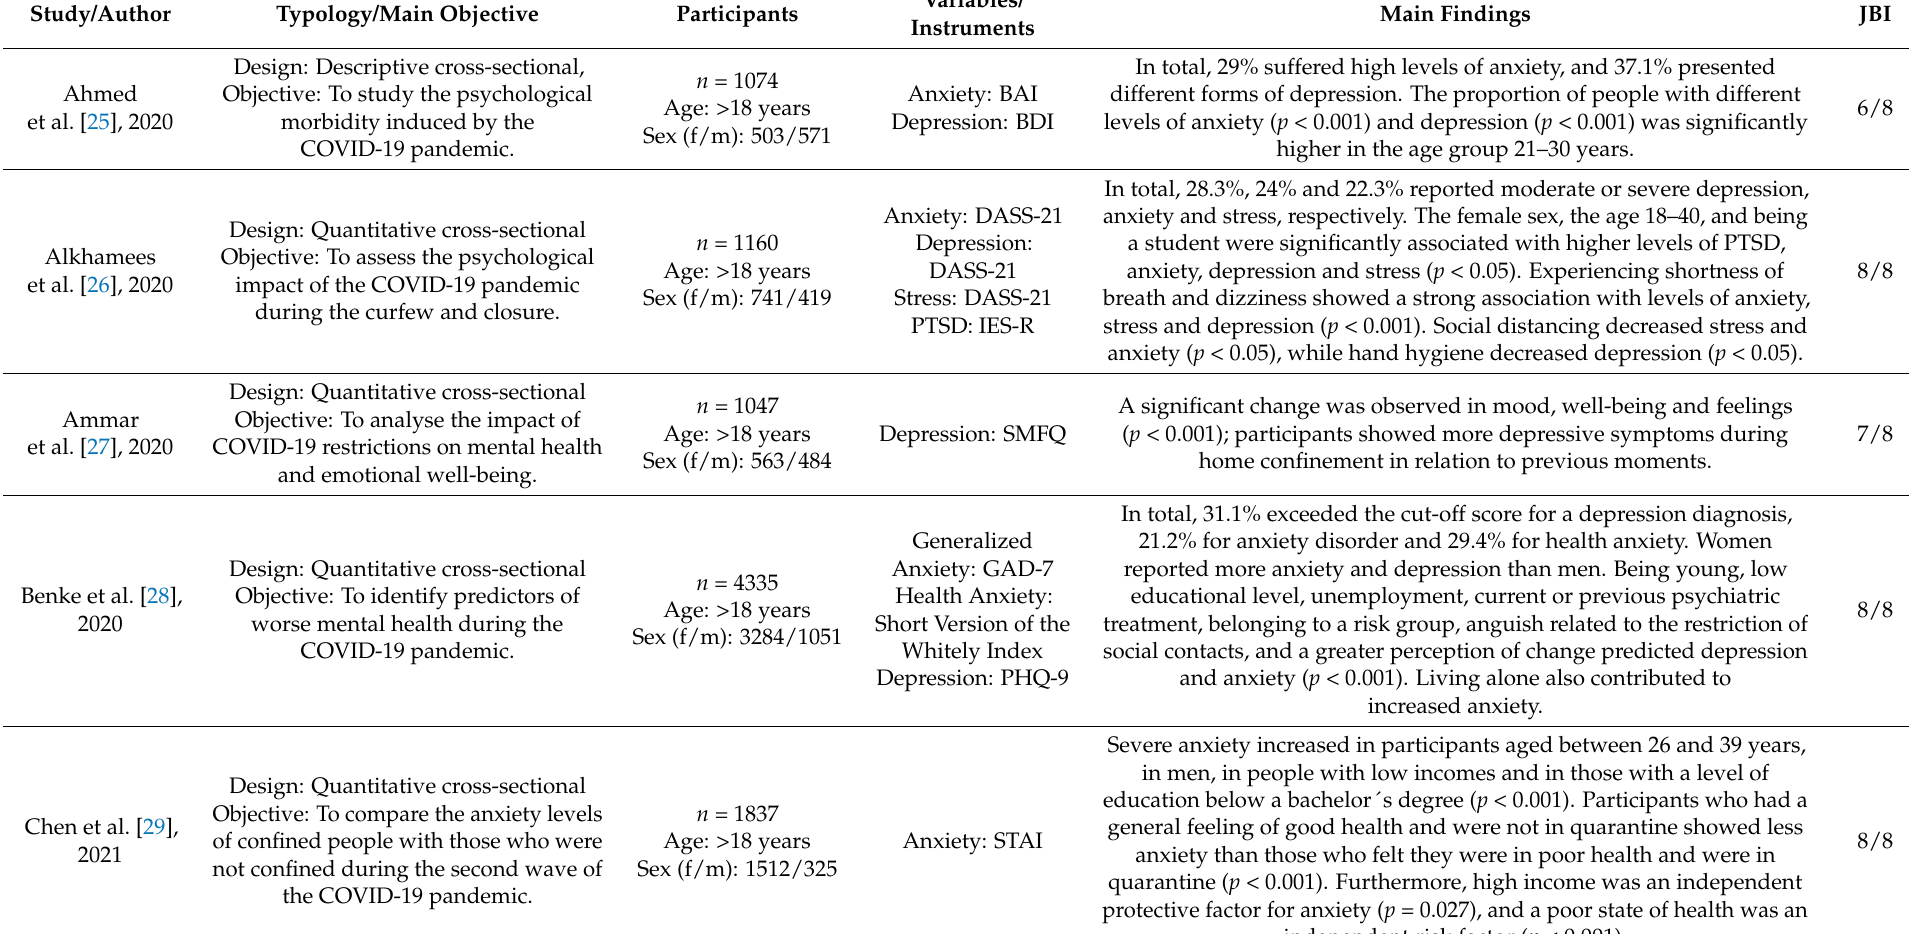
Table 3. Characteristics of the studies included in the systematic